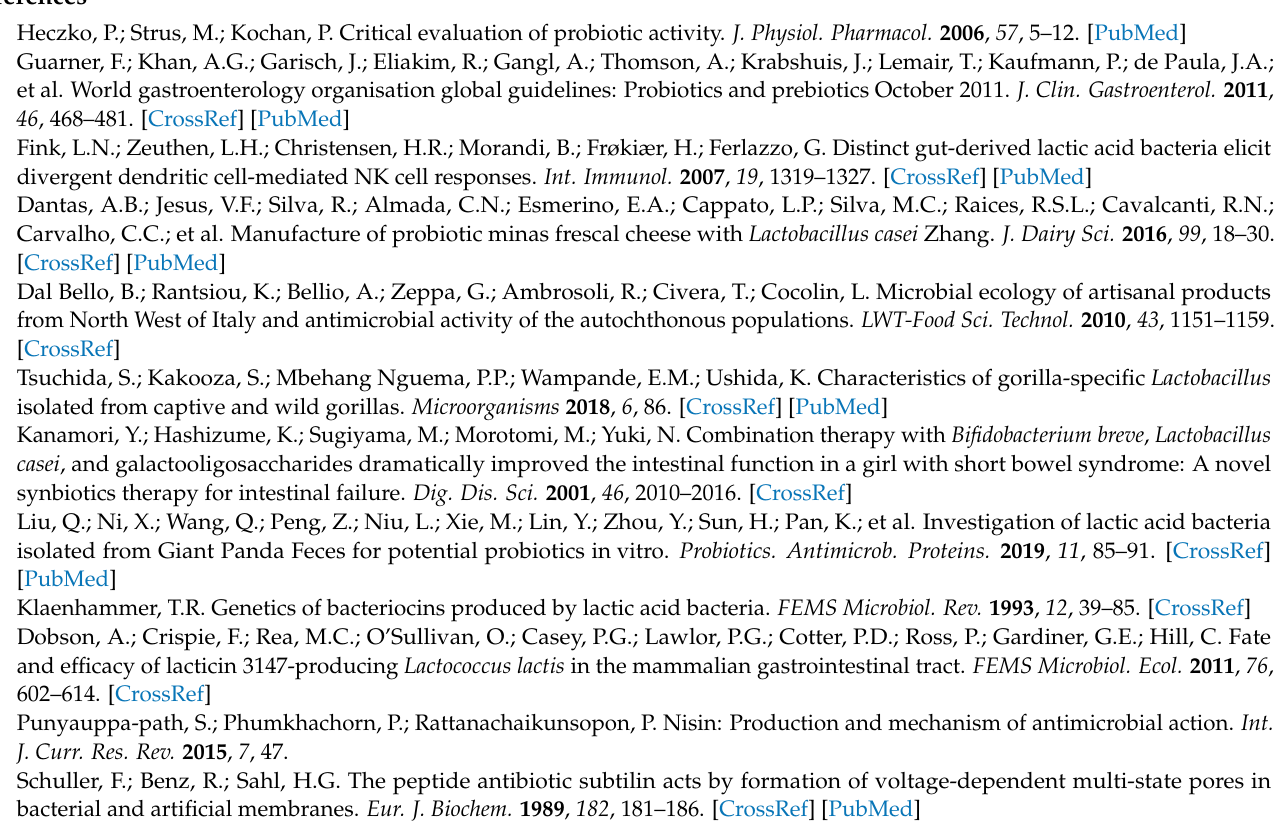
Figure S3: RAPD-PCR bands patterns of five Lactococcus lactis subsp. lactis strains. Lane M: molecular weight ladder marker; lanes 1–5: strains CBW1–5. Figure S4: PCR results for nisin biosynthesis-related genes in five Lactococcus lactis subsp. lactis strains isolated from the fecal sample of a stranded female Cuvier’s beaked whale. Lane M: 100-bp ladder marker from 100 to 1000 bp